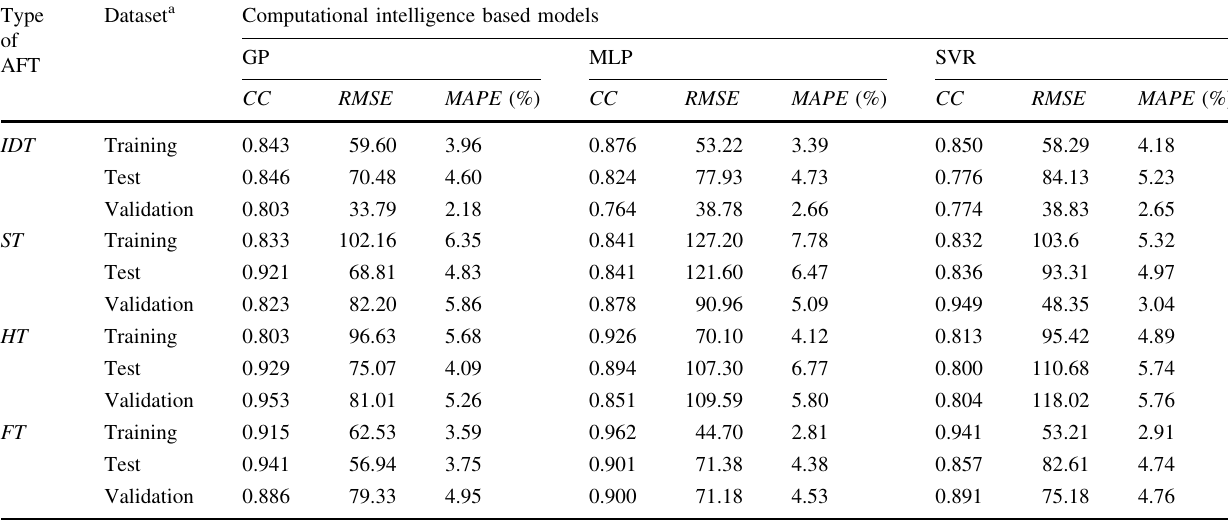
Table 3 Statistical analysis of the prediction accuracy and generalization performance of the GP-, MLP-, and SVR based models predicting IDT, ST, HT, and FT Type Dataset a of AFT